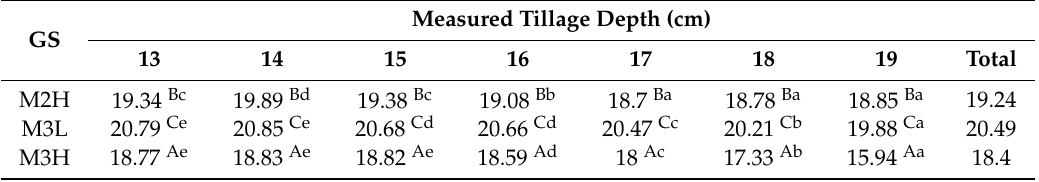
Table 10. Mean fuel rate (L / h) according to the tillage depth and gear selection (GS).